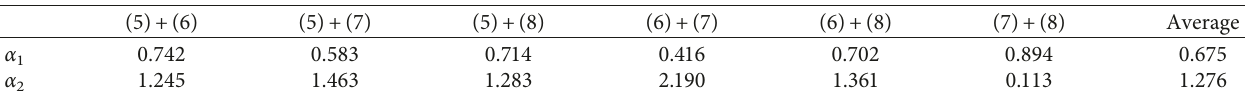
Figure 10: (a) Compressive strength, (b) elastic modulus, and (c) axial deformation of specimens with different carbon fiber Table 5: Value of α 1 and α 2 .